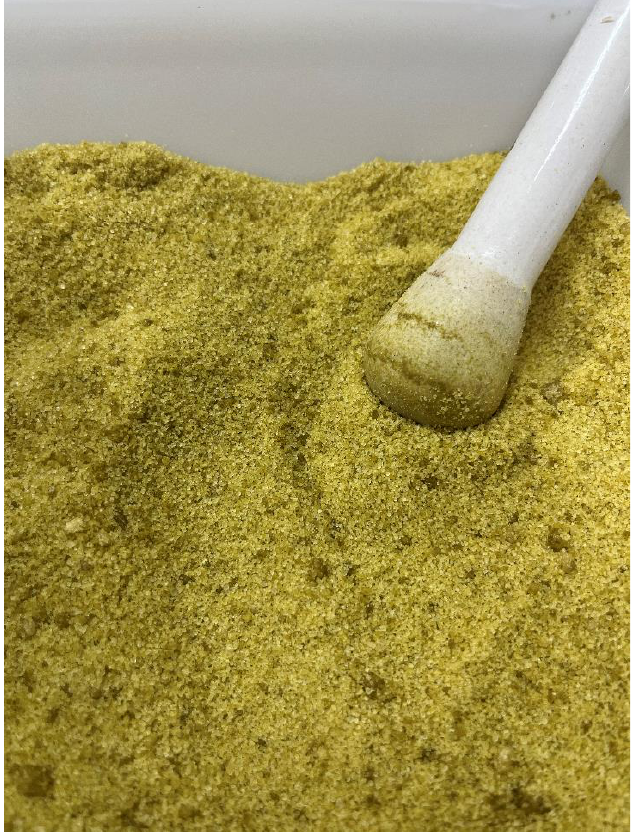
Figure 6. Solid formulation of Piper nigrum fruit ethanolic extracts produced by ASE-150/ultrasound assisted maceration (UAM) extraction.